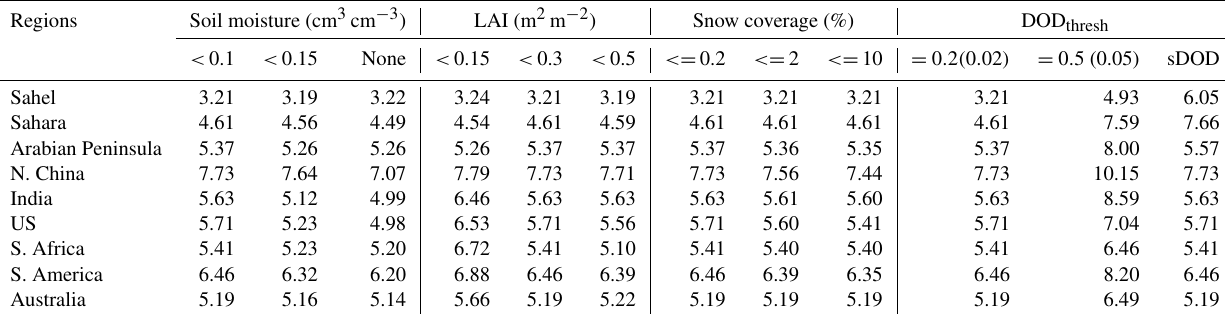
Table 2. Sensitivity of the annual mean wind erosion threshold (ms − 1 ) to the selection of different retrieval criteria. Note the setting of the last column is the same as DOD thresh = 0 . 2 or 0.02, except surface DOD (sDOD) from Aqua is used over northern Africa. Here DOD thresh = 0 . 2 or 0.5 is applied to dusty regions, i.e., the Sahel, Sahara, Arabian Peninsula, northern China, and India, while DOD thresh = 0 . 02 or 0.05 is applied to less dusty regions, i.e., the US, South Africa, South America, and Australia. Regions